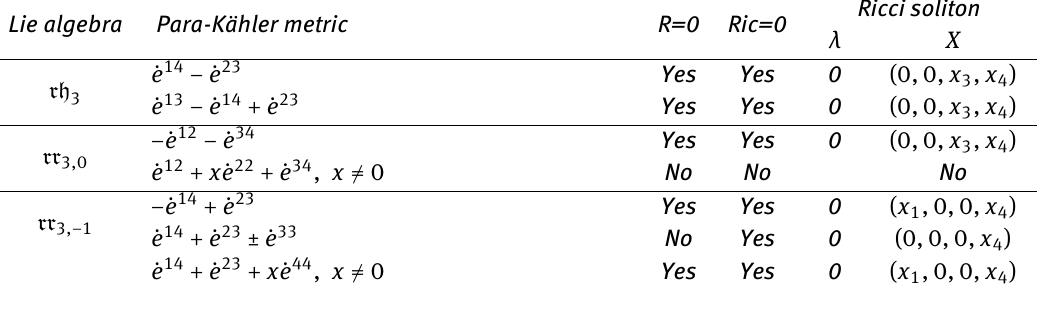
Table 3: Curvature properties of four-dimensional para-Kähler Lie algebras Lie algebra Para-Kähler metric R=0 Ric=0 ˙ e 14 − ˙ e 23 Yes Yes 0 (0, 0, x 3 , x 4 ) rh 3 ˙ e 13 − ˙ e 14 + ˙ e 23 Yes Yes 0 (0, 0, x 3 , x 4 ) −˙ e 12 − ˙ e 34 Yes Yes 0 (0, 0, x 3 , x 4 ) rr 3,0 −˙ e 14 + ˙ e 23 Yes Yes 0 ( x 1 , 0, 0, x 4 ) rr 3,−1